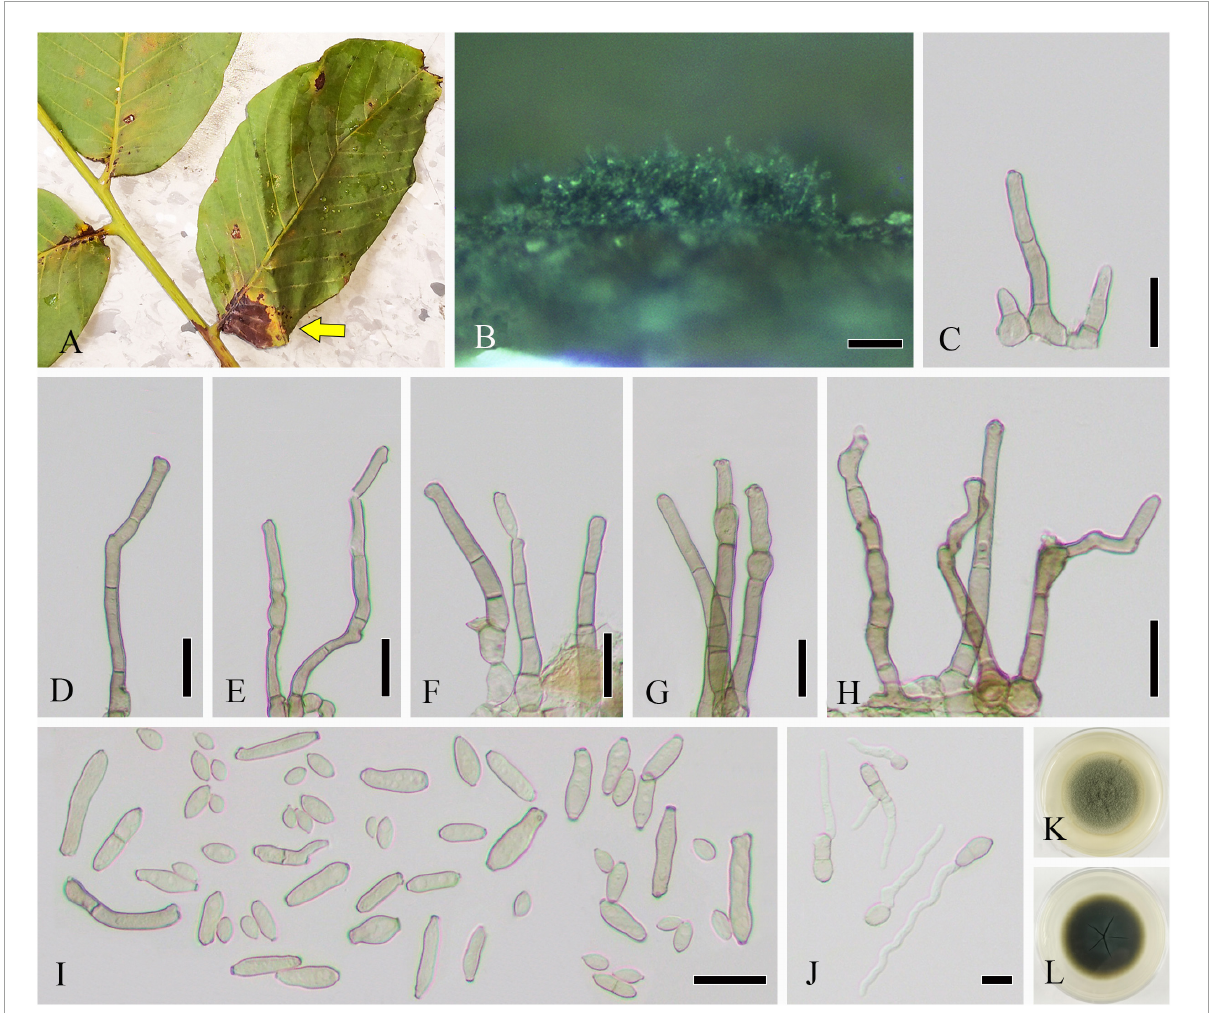
FIGURE1 Cladosporium tenuissimum (SICAU 22-0109). (A) Symptoms of necrotic lesions observed on host. (B) Appearance of colonies on substrate. (C–H) Conidiophores. (I) Ramoconidia and conidia. (J) Germinating ramoconidia and conidia. (K,L) Colonies on PDA for 10 days. Scale bars: (B) 100 µ m and (C–J) 20 µ